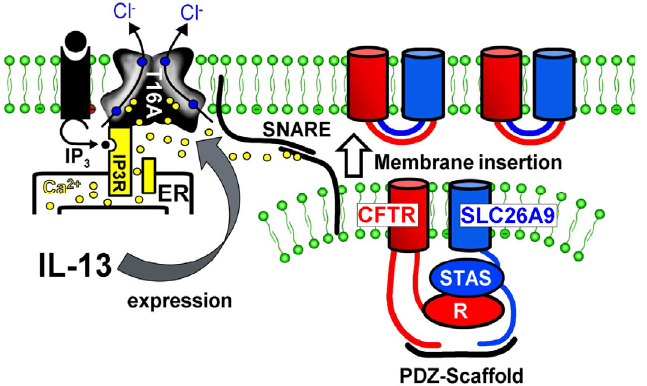
Figure 7. Enhanced membrane expression of SLC26A9 in asthma. Proposed mechanism for enhanced SLC26A9 expression in airways exposed to IL-13. Exposure to IL-13 leads to enhanced expression of TMEM16A. TMEM16A expressed in the apical membrane tethers the endoplasmic reticulum (ER) to the apical membrane and leads to enhanced compartmentalized Ca 2+ signalling. Enhanced intracellular apical Ca 2+ concentrations facilitate membrane insertion of CFTR and SLC26A9 via the Ca 2+ -regulated SNARE (soluble N -ethylmaleimide-sensitive factor attachment protein receptor) complex.